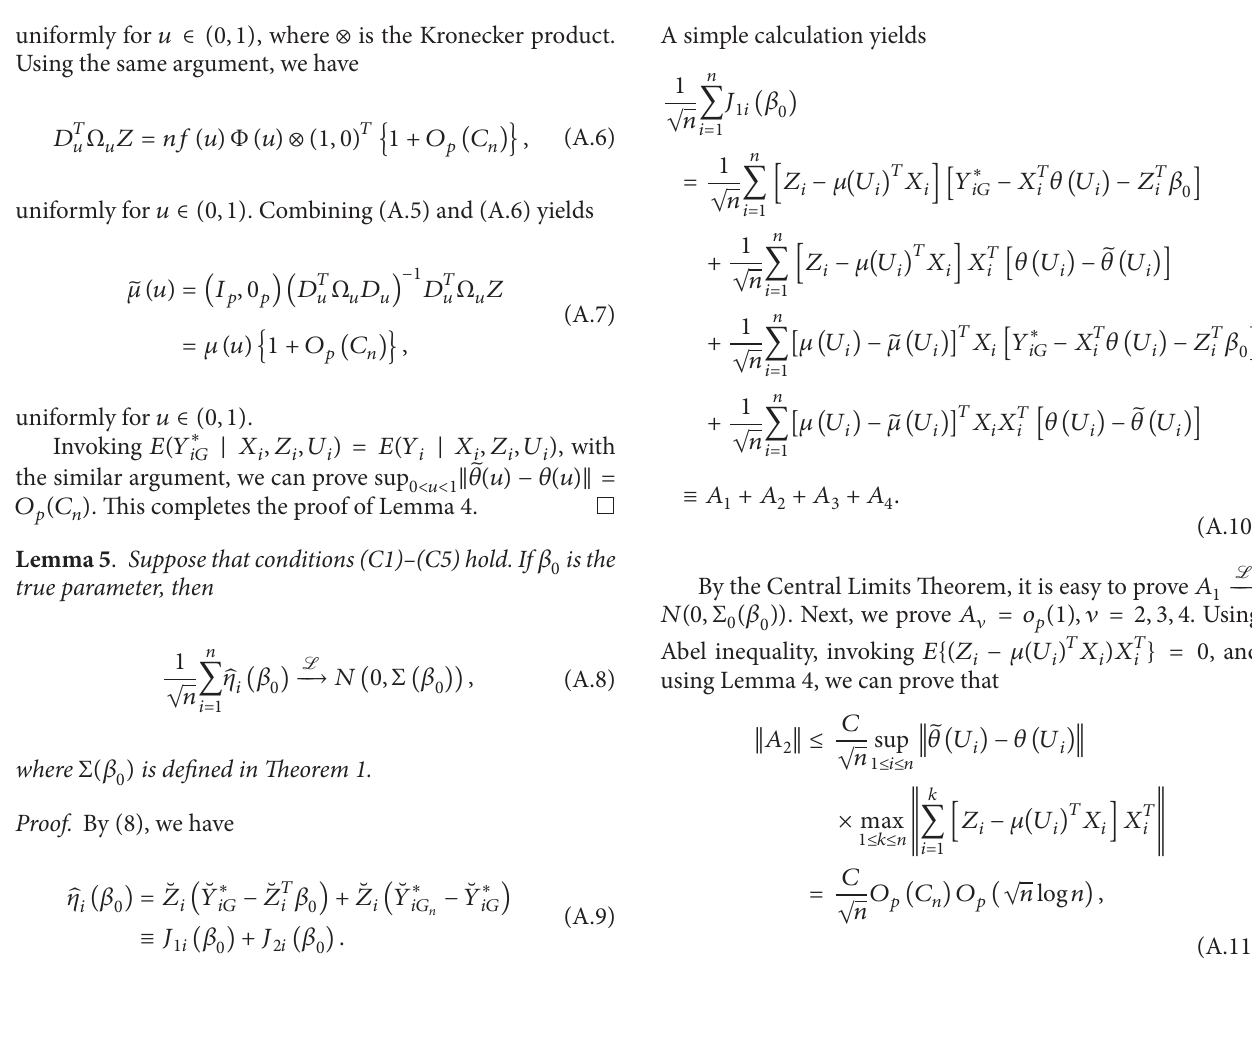
con�dence intervals (CI) for the %